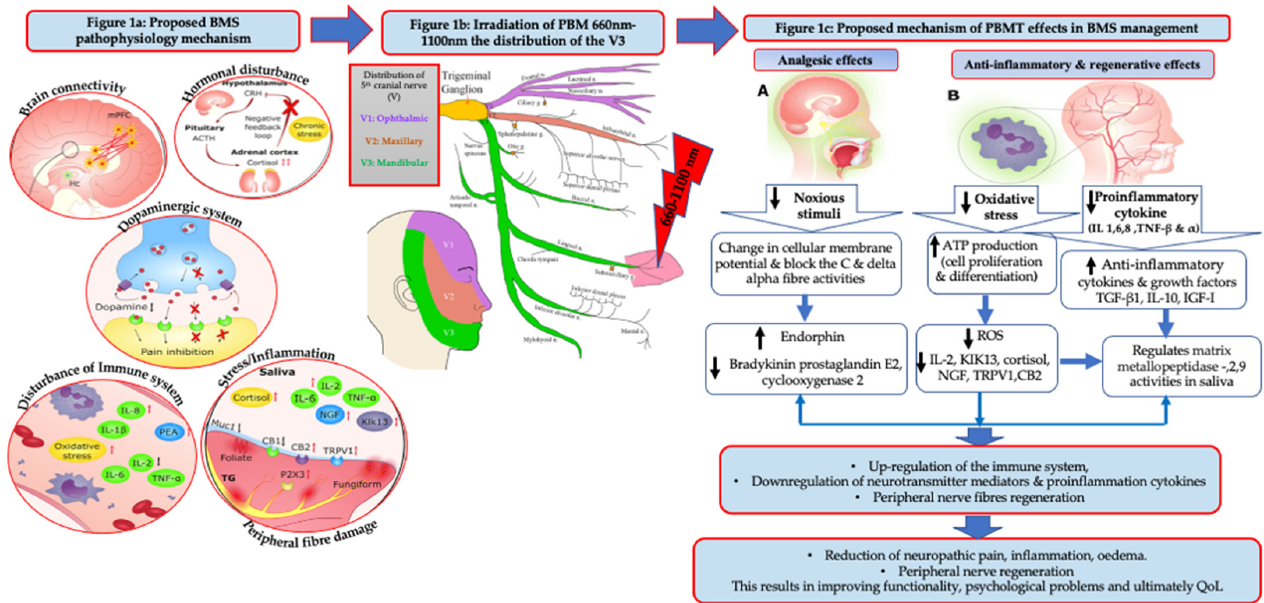
Figure 1. ( a – c ). Schematic representation of the proposed BMS pathophysiology mechanism ( a ) and PBM-irradiation of the tongue (main target) where it shows the irradiation of the V3 distributions ( b ) and proposed mechanism of action of PBM in BMS management ( c ). In Figure 1c, “A“ represents the analgesic effects of PBMT whereas “B” represents the anti-inflammatory and regenerative effects of PBMT. Abbreviations: BMS: burning mouth syndrome; IL: Interleukin; TNF- β and α : transforming necrosis factor-beta and alpha; NGF: nerve growth factor; TRPV-1: transient receptor potential cation channel subfamily V member 1; ROS: reactive oxygen species; ATP: adenosine triphosphate; MMP-1,2,9: matrix metalloproteinases-1,2,9; PBM: photobiomodulation; nm: nanometre; V3: mandibular branch of the 5th cranial nerve (trigeminal nerve).